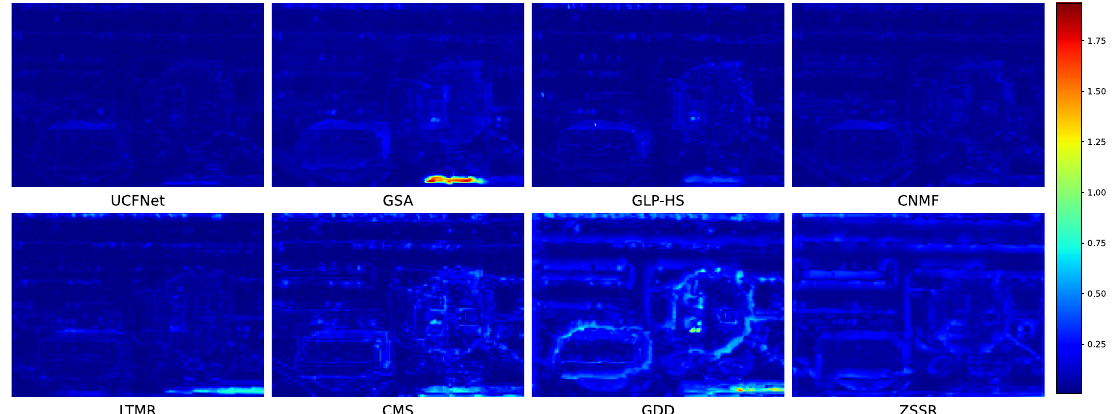
Figure 10. Error maps, the SHARE-2010 dataset, the scaling factor is 8.